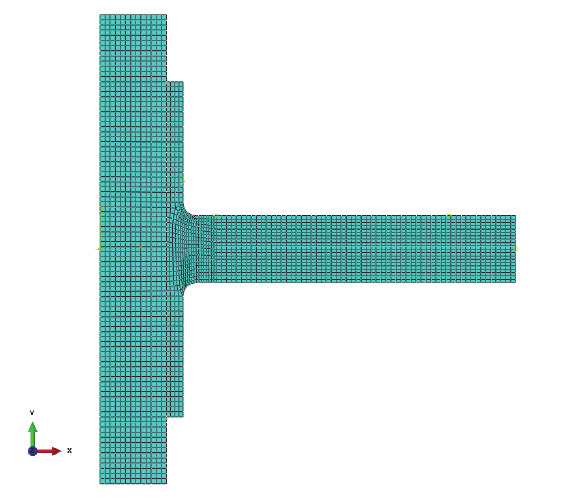
Figure 8: FE model mesh.